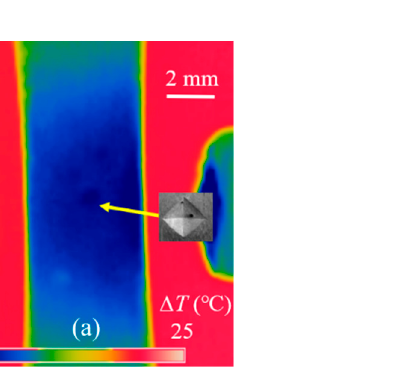
crack initiation was independent of the indent.